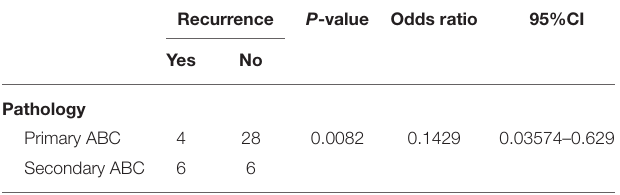
TABLE 2 | Relationship of pathology and recurrence rate (Chi-square test).